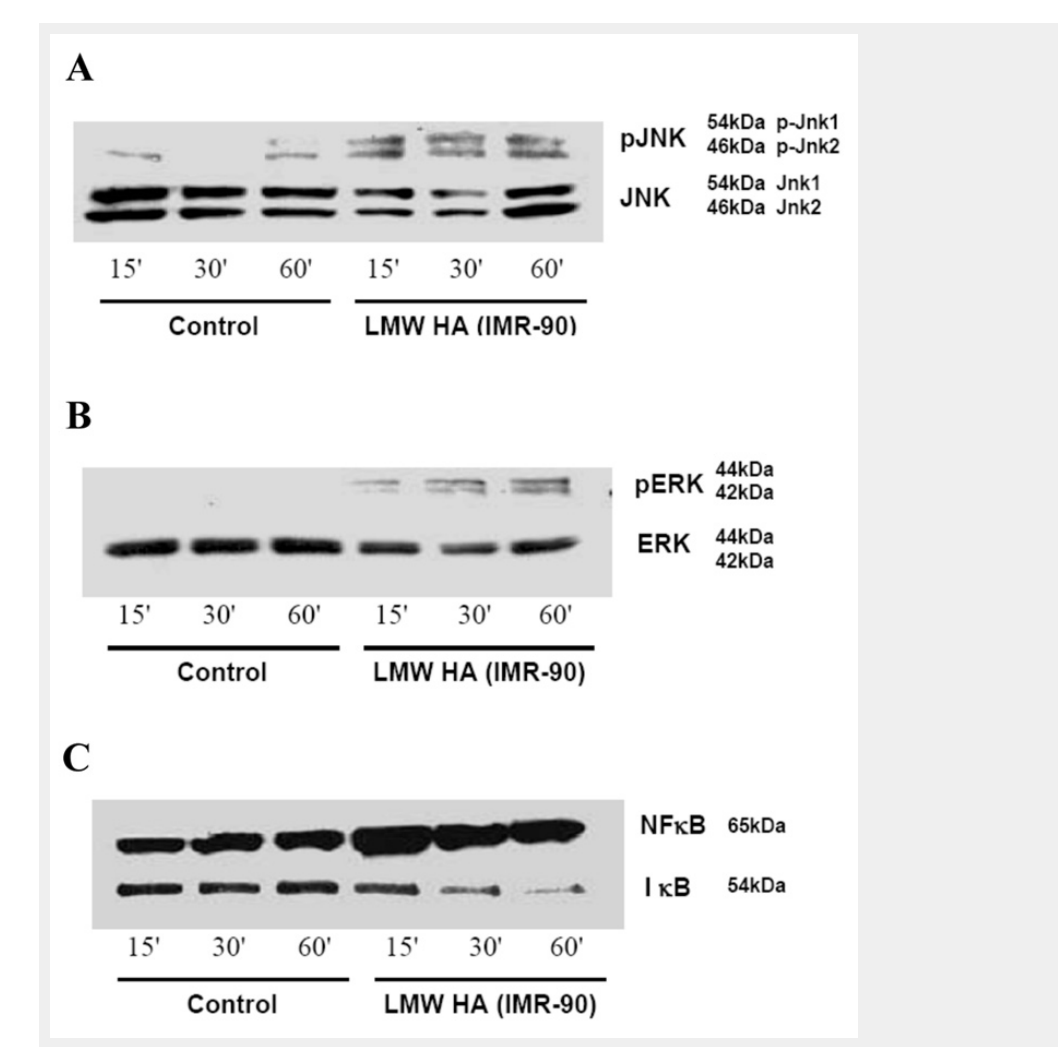
Figure 3 LMW-HA from stretched foetal lung fibroblasts (IMR 90 cells) activated the JNK, ERK and NF-κB/IκB pathways in human BEAS-2B bronchial epithelial cells. Western blot analysis: A. c-jun N-terminal kinase; B. ERK-1 and ERK-2; and C. NFκB in nuclear fraction/ IκB in cytosolic fraction. Each blot is representative of 3 separate